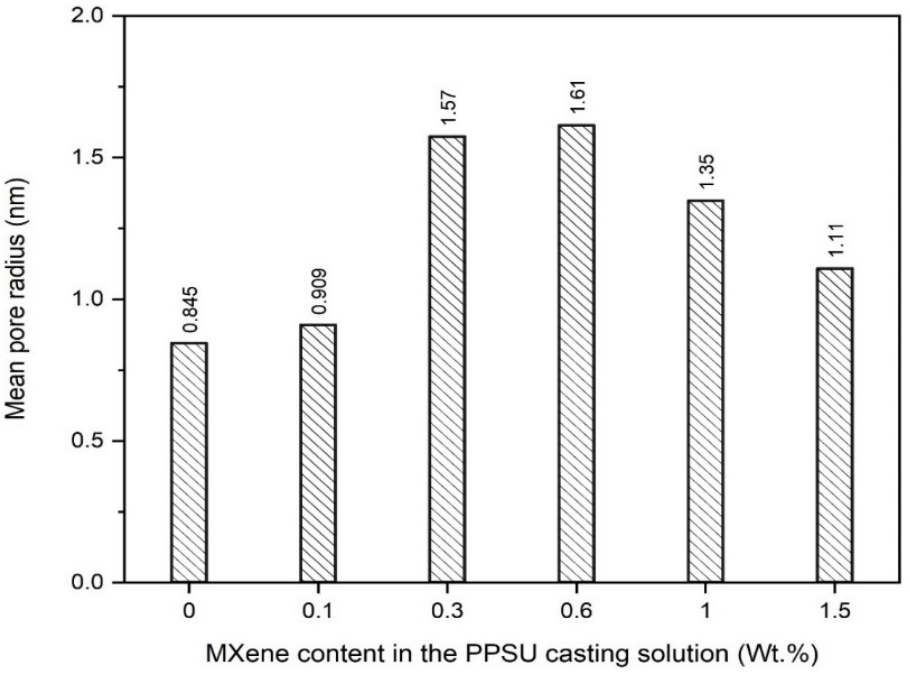
Figure 8. In fl uence of MXene content on the mean pore size of the NF nanocomposite membranes.